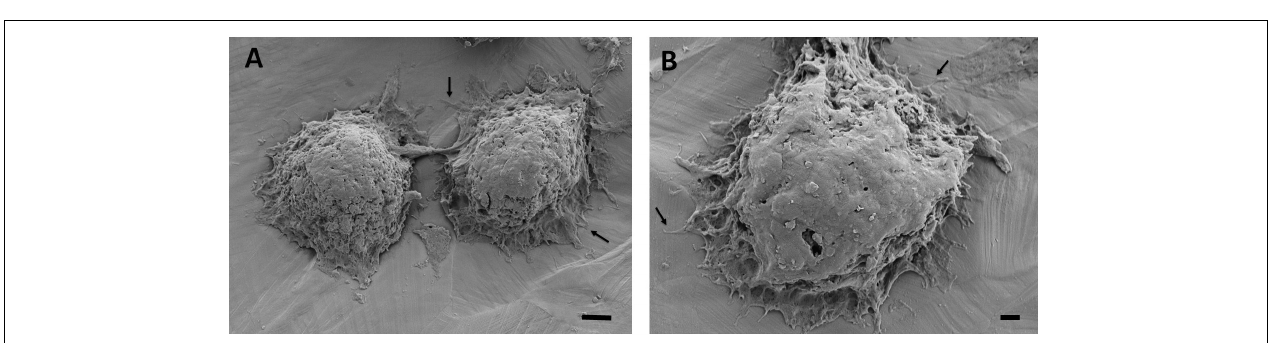
FIGURE 6 | Scanning electron microscopy images of the breast cancer cells attached on the undeformed stainless-steel samples. Figure in (A) shows two neighboring cells and (B) shows a single cell with higher magnification. Arrows point out the cytoplasmic protrusions. Scale bars are 3 and 2 µ m, respectively.